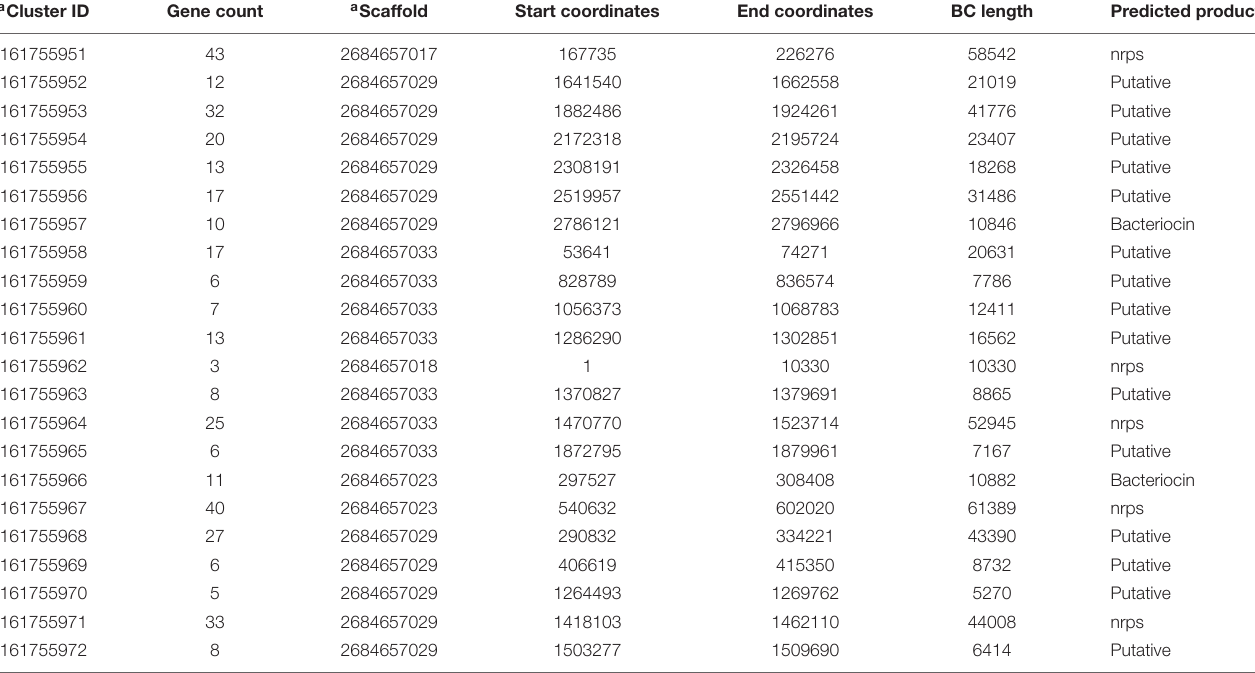
TABLE 3 | Biosynthetic gene cluster (BGCs) identified in strain 06C